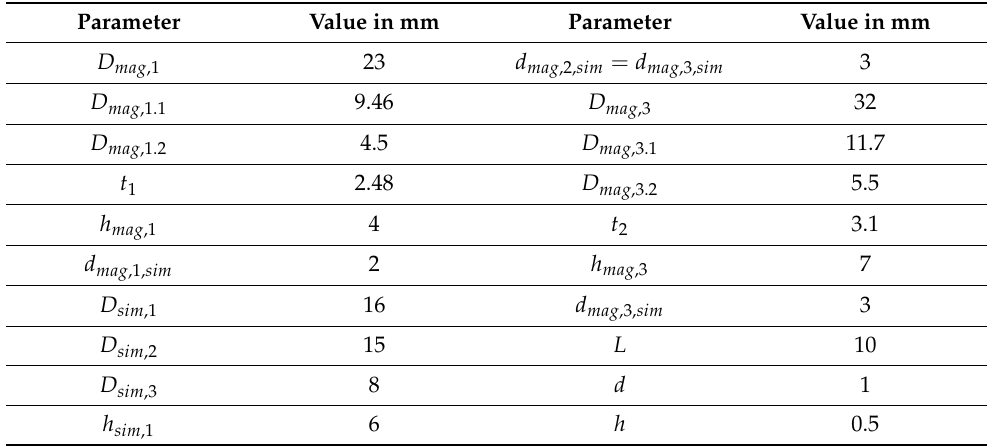
Figure A3. Parameters of the simulated geometries. The setup on the left was used for the enrichment of drug-loaded SPIONs, while the setup on the right was used for SPION-loaded cells. Table A1. Values for the parameters of the simulation form Figure 2. Parameter